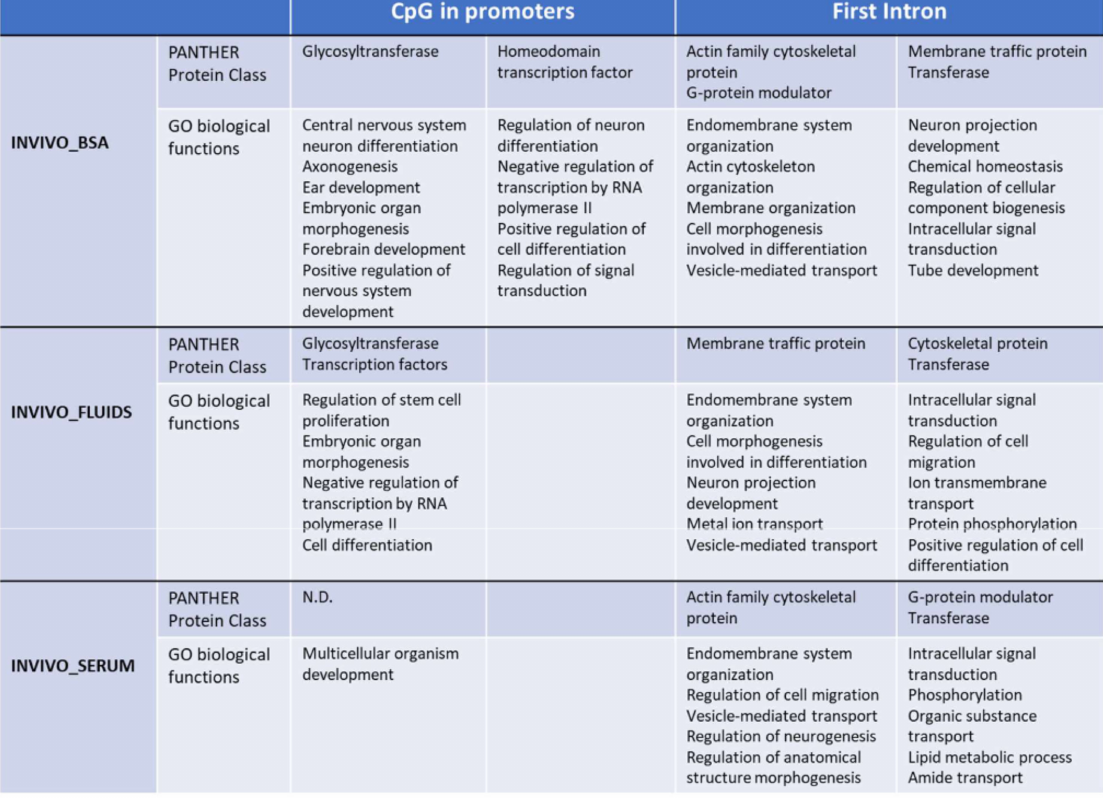
Figure 4. Functional annotation using PANTHER. GO biological functions and Panther pathways overrepresented in the CpG islands in promoters or FIRST introns with differential methylation between INVIVO and the other three groups are shown. Fisher’s exact test using the Bonferroni correction for multiple testing was applied for statistical overrepresentation analysis. N.D: not